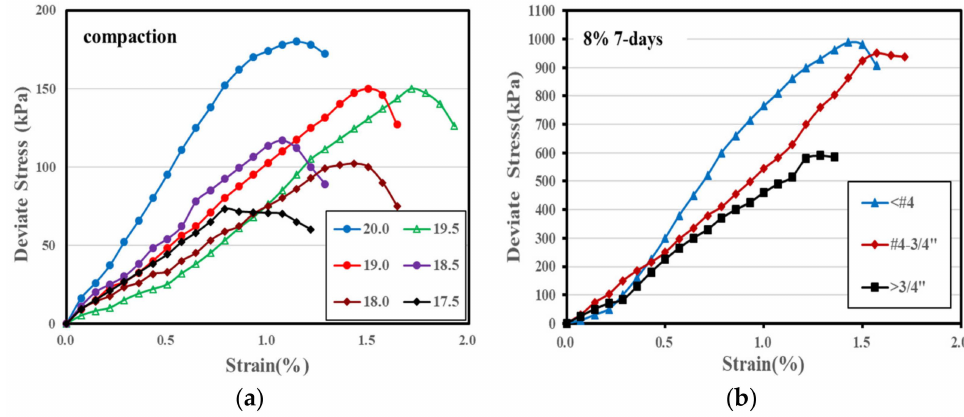
Figure 7. Deviate stress–strain curves of untreated and treated samples of unconfined compression test: ( a ) mudstone; ( b ) mudstone–cement.